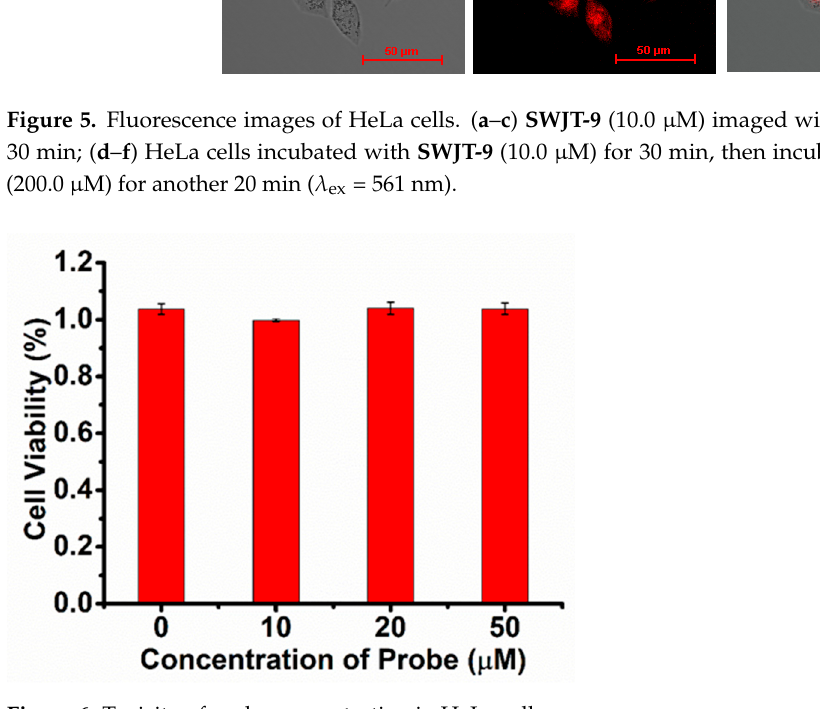
Figure 6. Toxicity of probe concentration in HeLa cells.